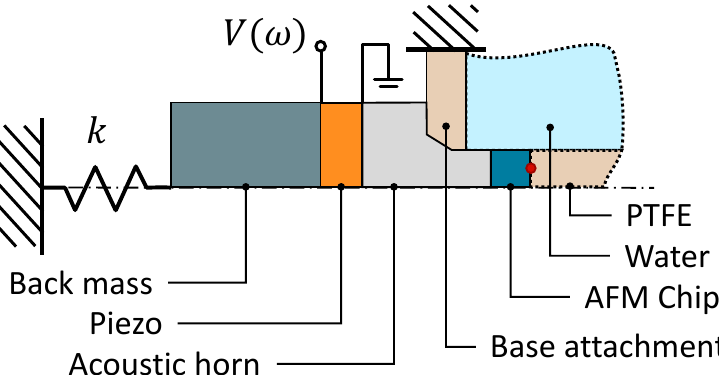
Figure 3. Axisymmetric view of the two-dimensional finite element model. The interface between the AFM chip and the PTFE, denoted by the red dot, was the point where the response of the chip base was calculated. The acoustic and solid mechanic domains are denoted by dotted lines and solid lines, respectively.